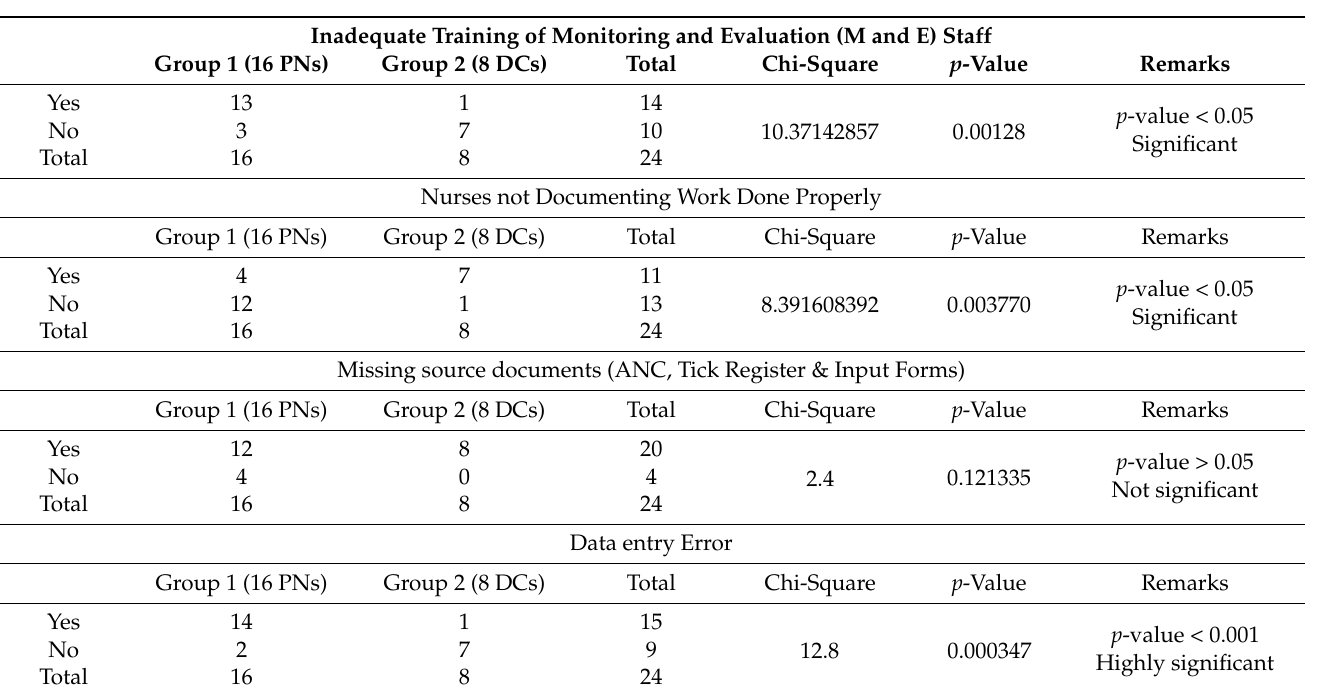
Table 2. Major causes of PTMCT data